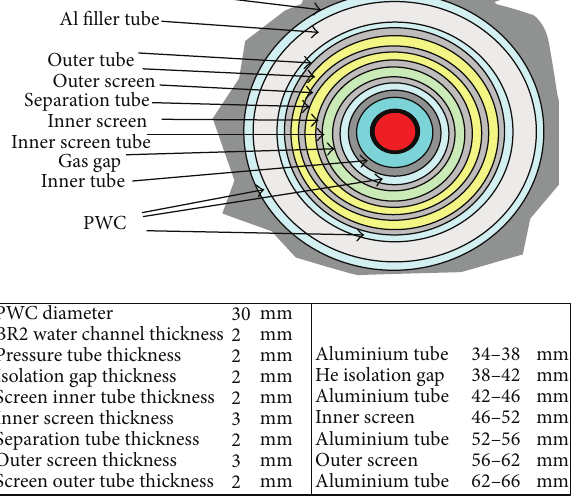
Figure 30: Horizontal cross-section of VANESSA with dimensions